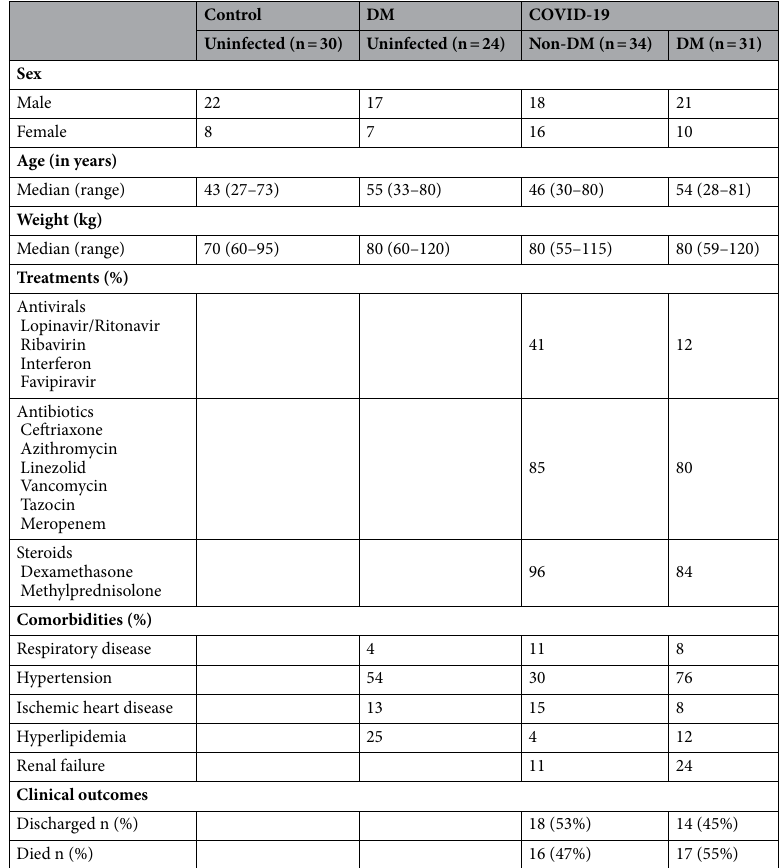
Table 1. Demographic data of the uninfected controls and ICU COVID-19